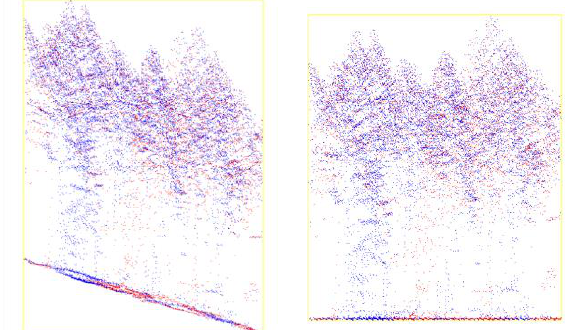
Figure 6. Discrete lidar point cloud clipped to the GEDI footprint, before (left) and after (right)